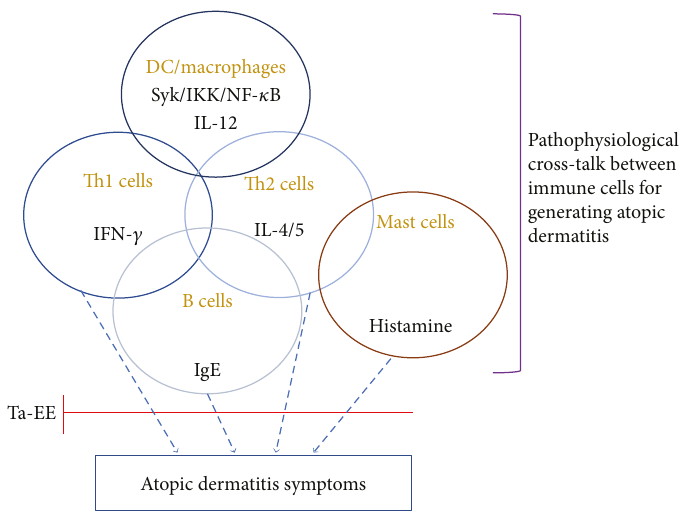
Figure 7: Putative inhibitory pathway of Ta-EE-mediated antidermatitis